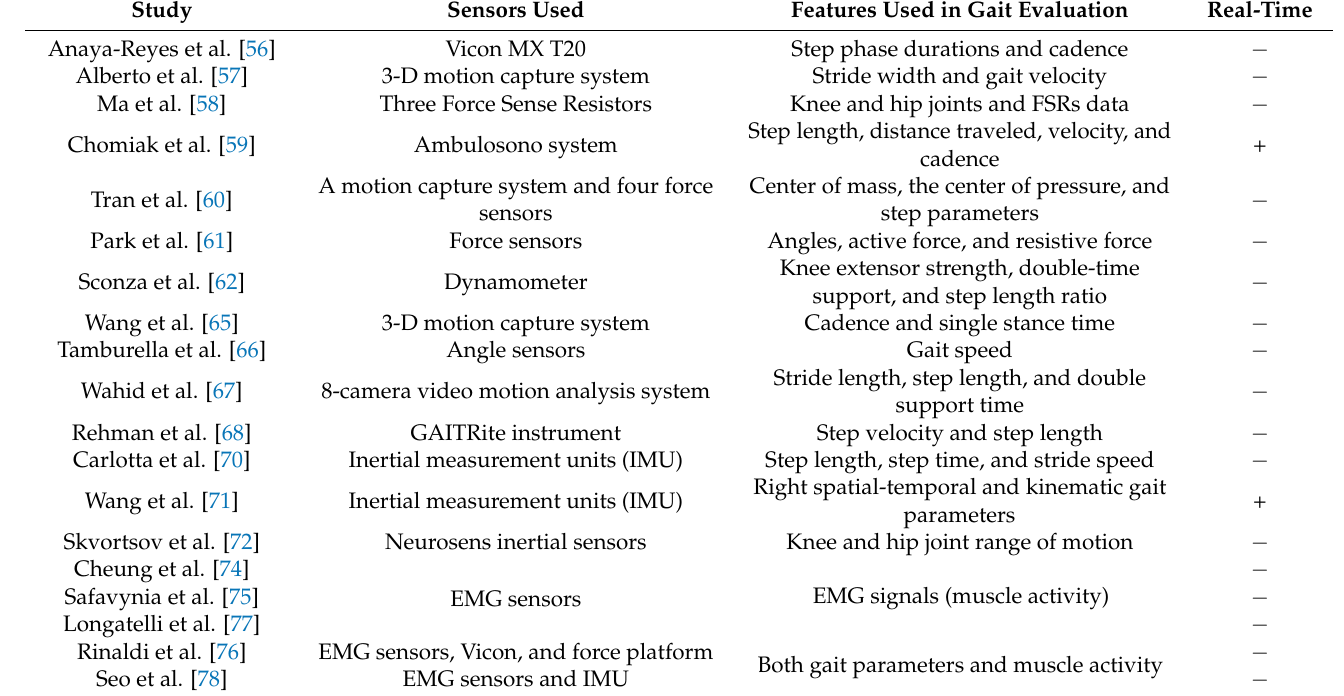
Table 3. Sensors and features used in gait evaluation method in each of the included